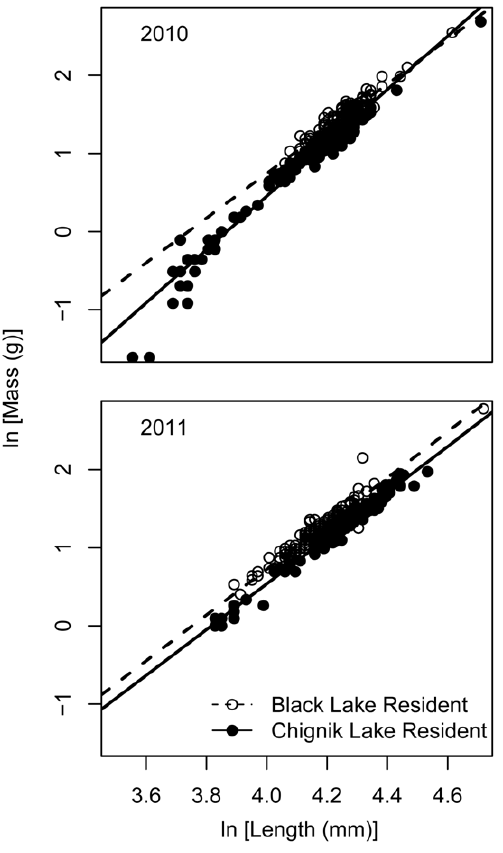
Figure 3. Length-mass relationship for sockeye salmon rearing in their natal lake of origin. These populations are referred to in the text as Black Lake residents and Chignik Lake residents. Circles are individual fish and the lines represent the AICc selected model. For 2010 the best model included different intercepts and slopes by natal lake of origin and capture. For 2011 while the best model included different intercepts and the same slope by natal lake of origin and capture, two other models were within 2 AICc units (Table